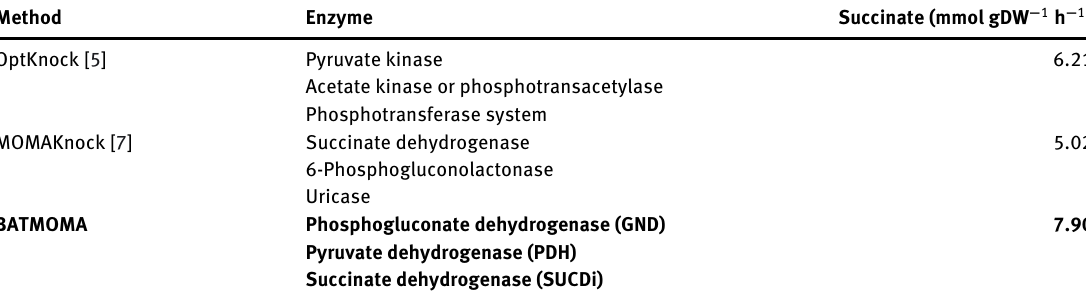
Table 2: Comparative analysis for succinate